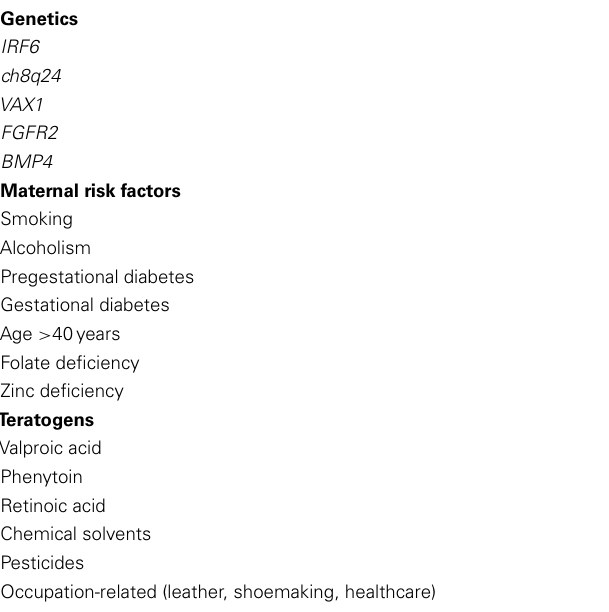
Table 2 | Reported etiologies of non-syndromic cleft lip with or without cleft